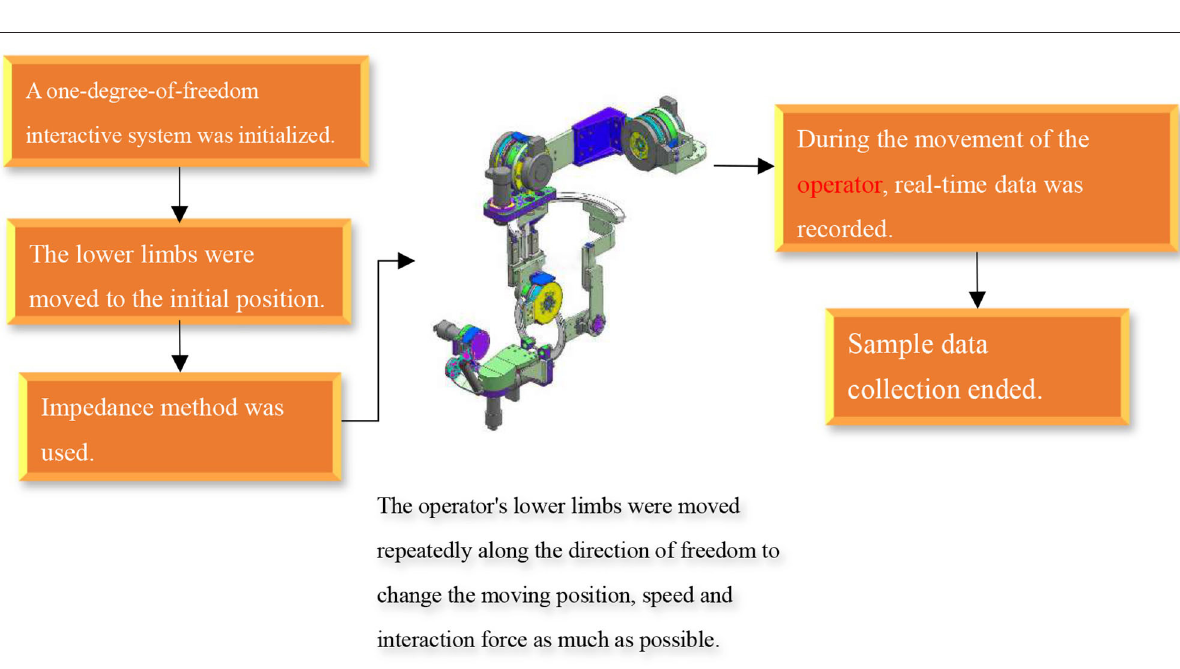
FIGURE 7 | Flowchart of data